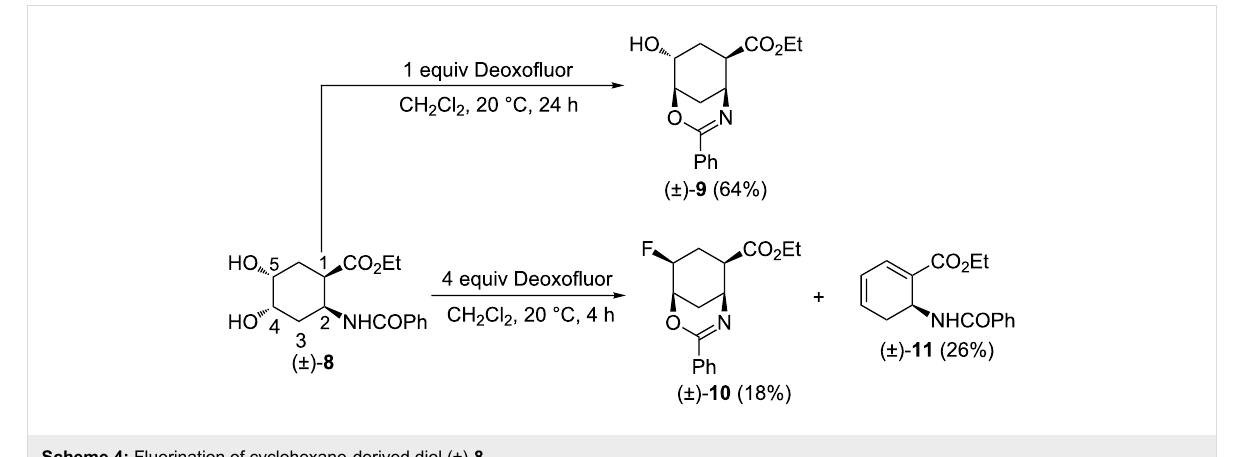
opening through olefinic-bond migration ( T10 ) then gives the highly conjugated amino acid ester (±)- 11 (Scheme